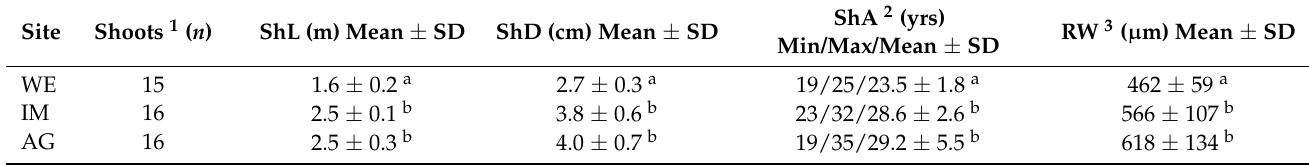
Table 1. Characteristics of selected Alnus alnobetula individuals (RW = ring width; SD = standard deviation; ShA = shoot age; ShD = shoot diameter; ShL = shoot length; sites: WE = wind-exposed ridge; IM = intermediate site; AG = avalanche gully). Statistically significant differences of mean values among individuals (=stocks) are indicated by different letters ( p ≤ 0.01; Student’s t -test).